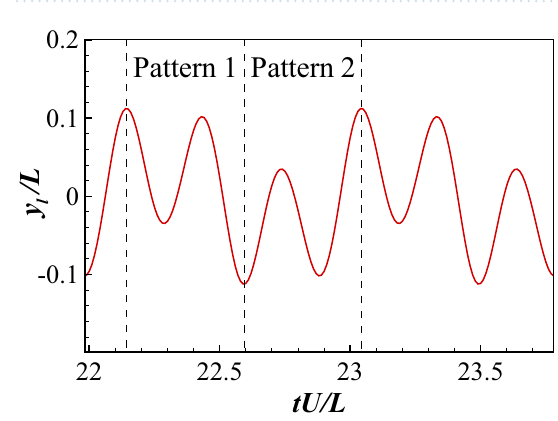
Figure 13. Rheotaxis: ( a ) the traces of the center of the mass for different initial orientations θ 0 ; and ( b ) the time history of the orientation angle for different initial orientations θ 0 .